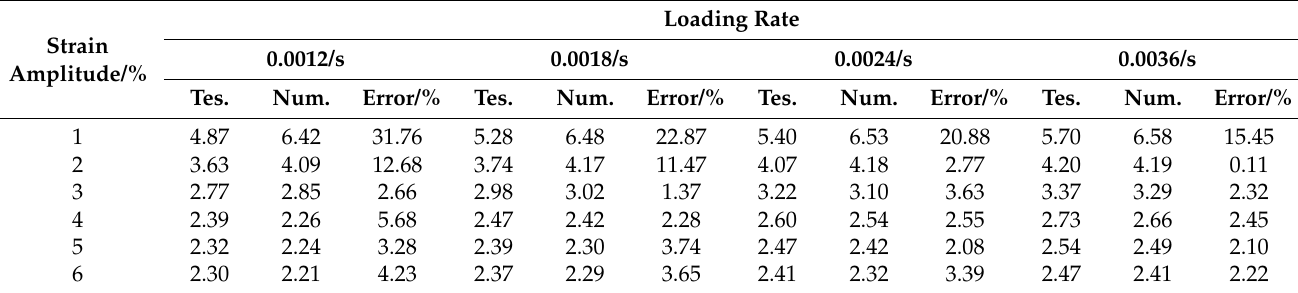
Table 7. Comparison of secant stiffness under different loading rates.